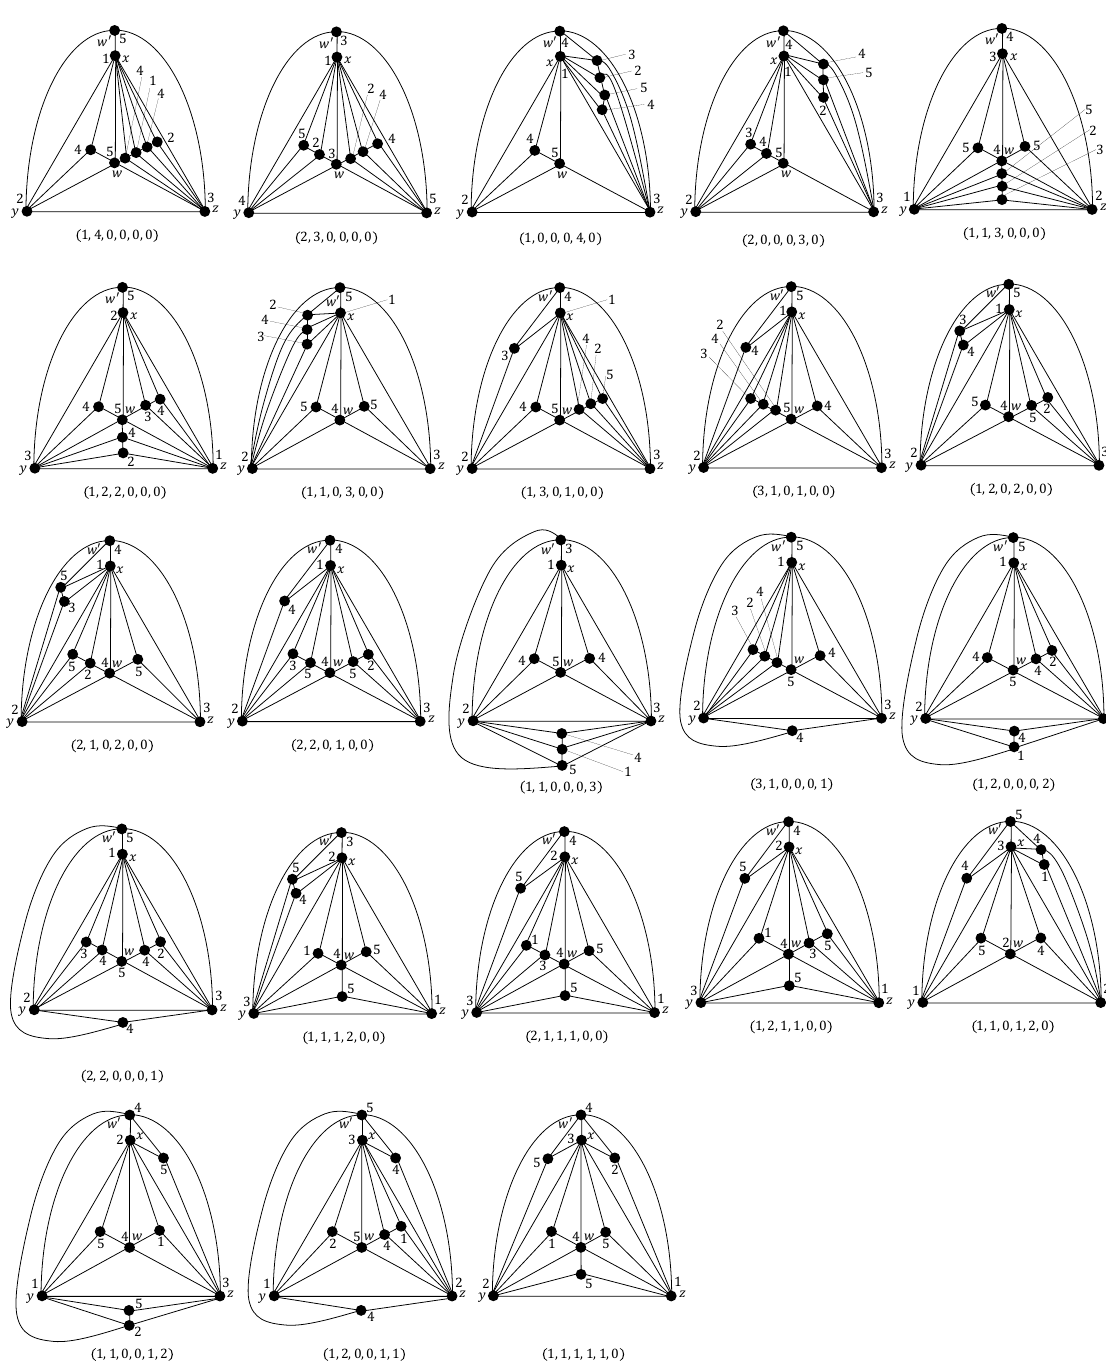
Figure 10: Facial 3-complete 5-colorings of G when G has w and w